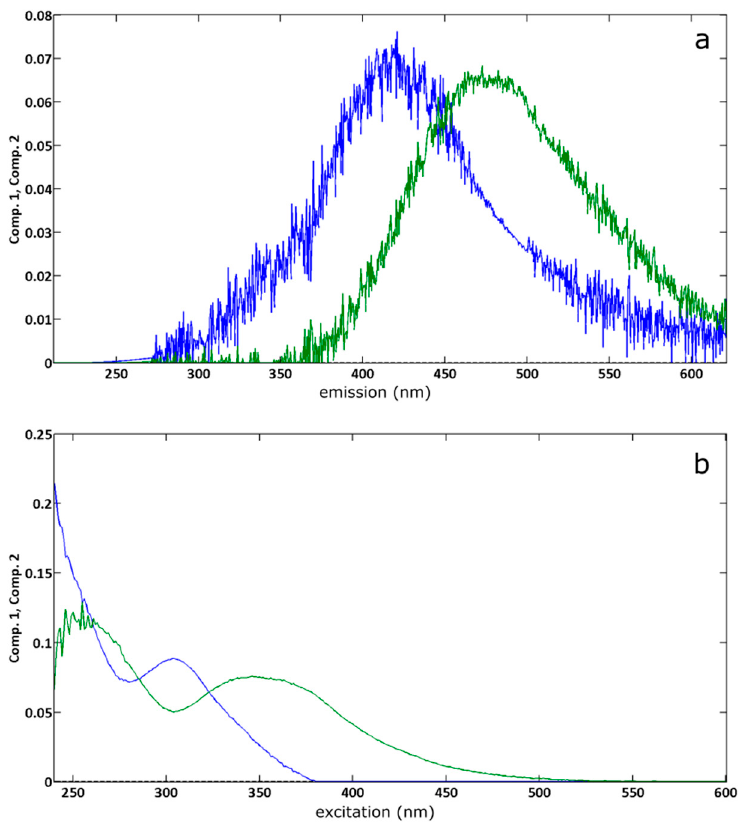
Figure 5. Emission ( a ) and excitation loadings ( b ) of the first component (blue) and the second component (green).